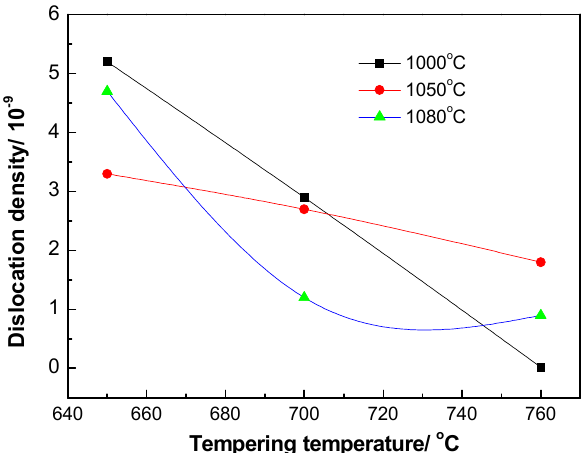
Figure 5. Variation in dislocation density with heat treatment temperature of 15Cr12MoVWN steel.